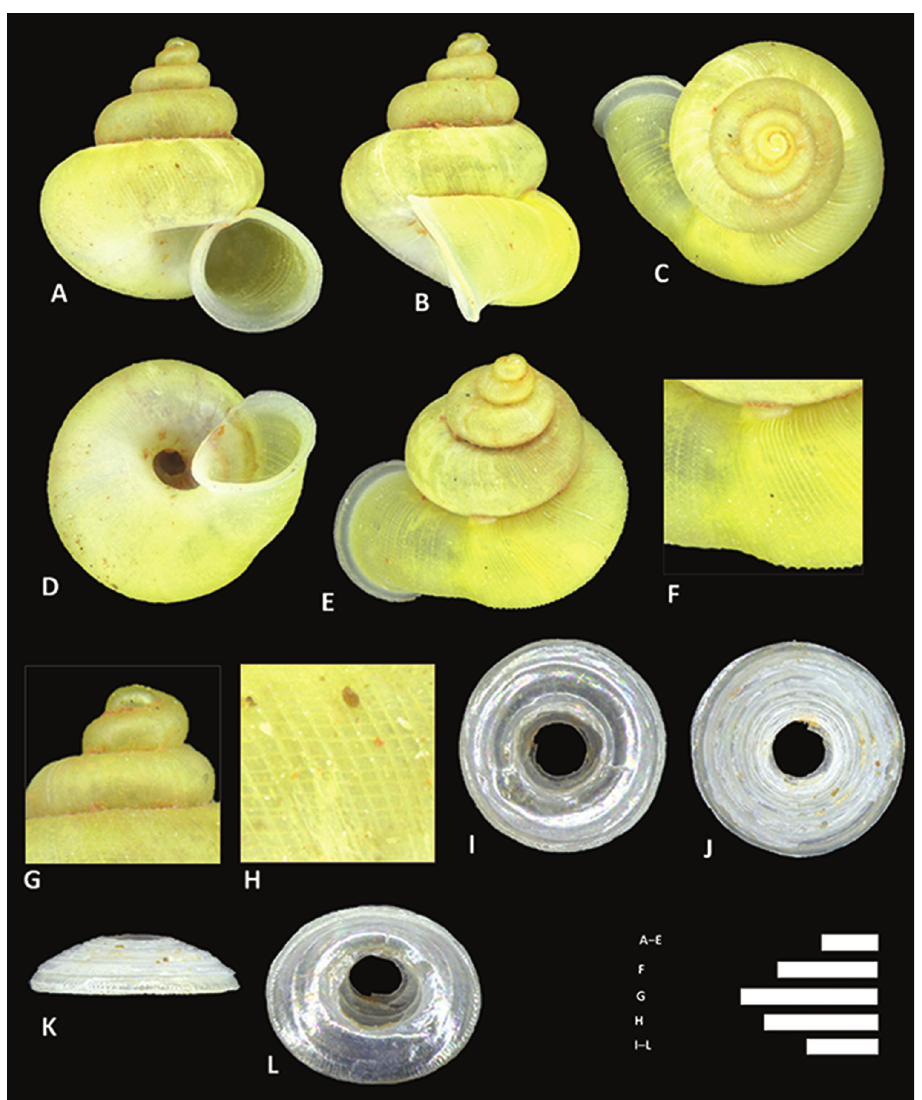
Figure 30. Alycaeus virgogravida sp. n. A–E Shell of holotype, BOR/MOL 12978 F–H Close up of shell of holotype, BOR/MOL 12978 I–L Operculum of holotype, BOR/MOL 12978. Scale bars: A–E, F, G 1 mm; H, I–L 0.5 mm. All photographs by Junn Kitt Foon.